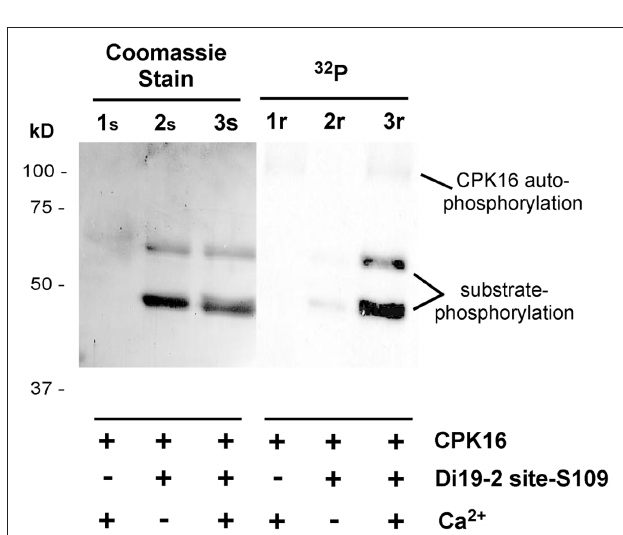
Figure 3 | Kinase reactions showing Ca 2 + -dependent phosphorylation of a Di19-site-S109 fusion protein (g-gFP-S109-ST) by CPK16. Three kinase reactions are shown on the left side after separation on an SDS-12% polyacrylamide gel and staining with Coomassie Brilliant Blue (1s,2s, 3s). The same gel is shown to the right as an autoradiogram to show the 32 P-labeling of phosphorylated proteins (1r, 2r, 3r). Kinase reactions were conducted as described in Section “Materials and Methods,” plus ( + ) or minus ( − ) Ca 2 + , with 1 μg of fusion protein substrate, 0.01 μg of kinase, in a 10-μL reaction. After a 10-min incubation, the entire reaction was subjected to SDS-PAGE. In control reactions, CPK16 did not phosphorylate the GST–GFP portion of the Di19-2-site-S109 fusion protein (e.g., see Figure 1 ). Note that the purified G-GFP-S109-ST fusion protein runs as two bands with apparent molecular weights of 48 and 60 kD. Results shown are representative of multiple independent analyses.